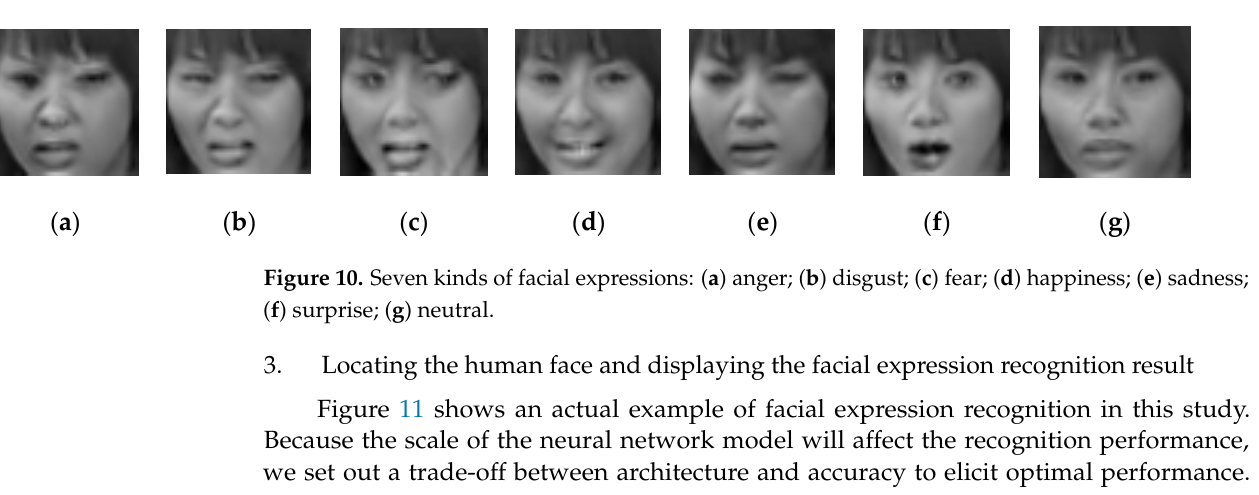
Figure 9. CNN architecture of human facial expression recognition.